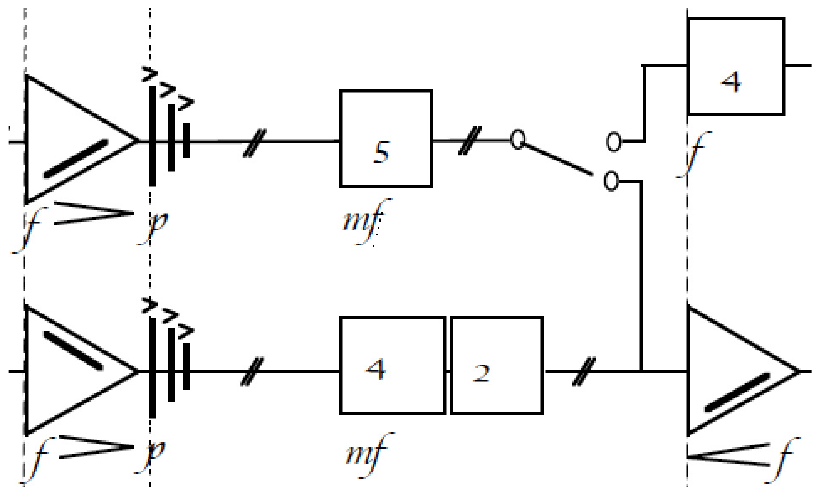
Figure 1. An excerpt from Short Circuit. One of my more open scores is 5x5 (2015) where the score is a matrix (Figure 2) of five events in five layers. The duration of the linear rows are determined at the time of each performance, and performance instructions are penned into the boxes before the